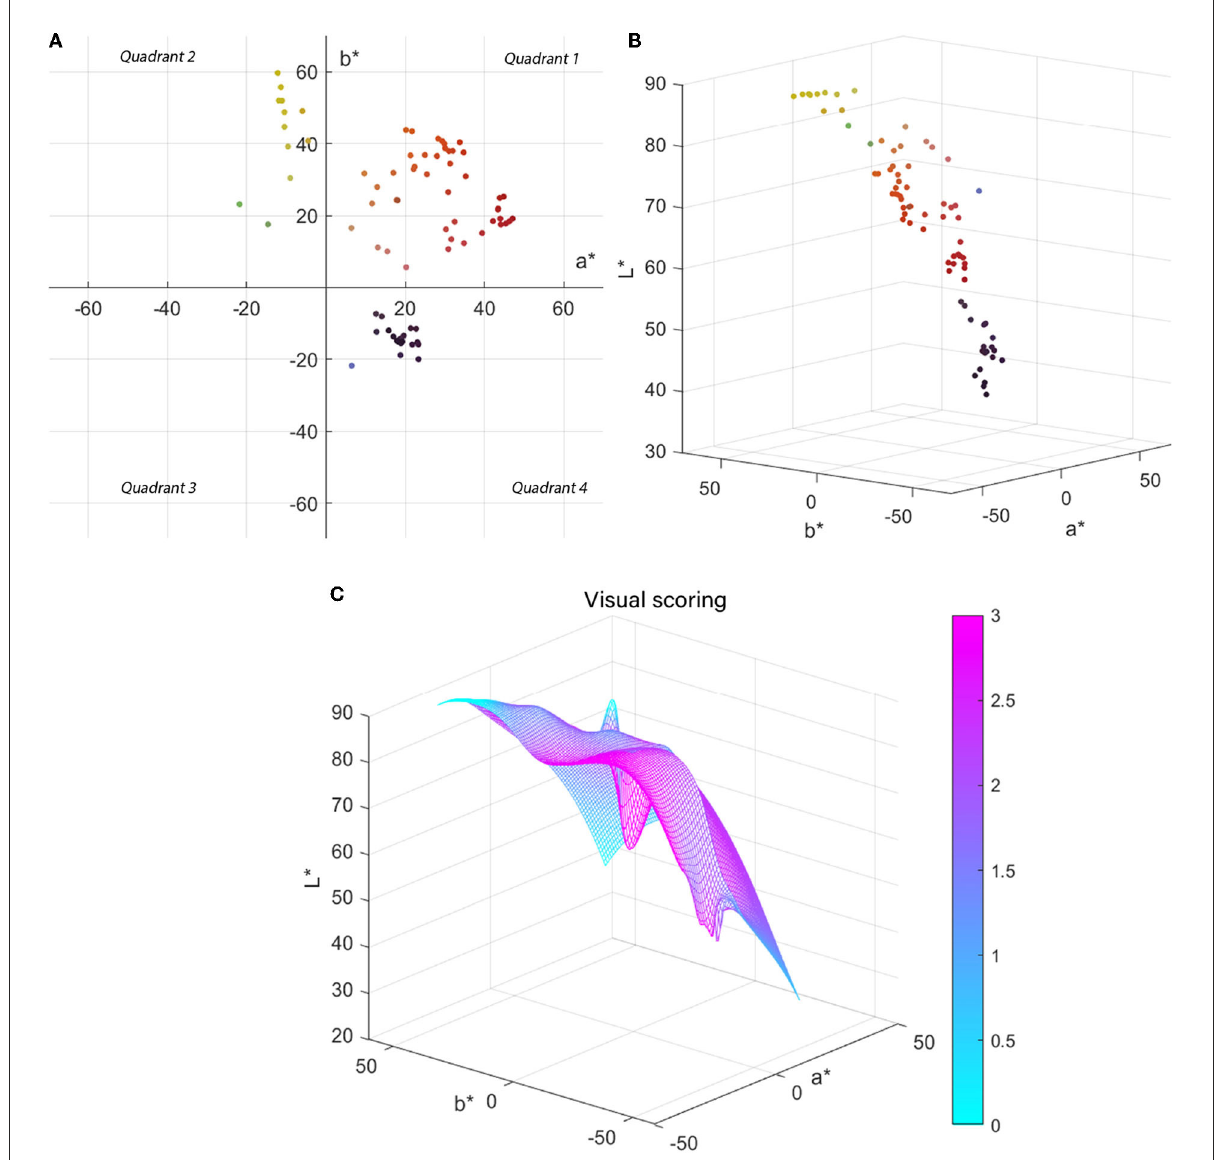
FIGURE8 (A) Two-dimensional distribution of 78 colors in CIELAB space. (B) Three-dimensional distribution of 78 colors in CIELAB space. (C) Correlation model of chromaticity value L*a*b* and human visual score.